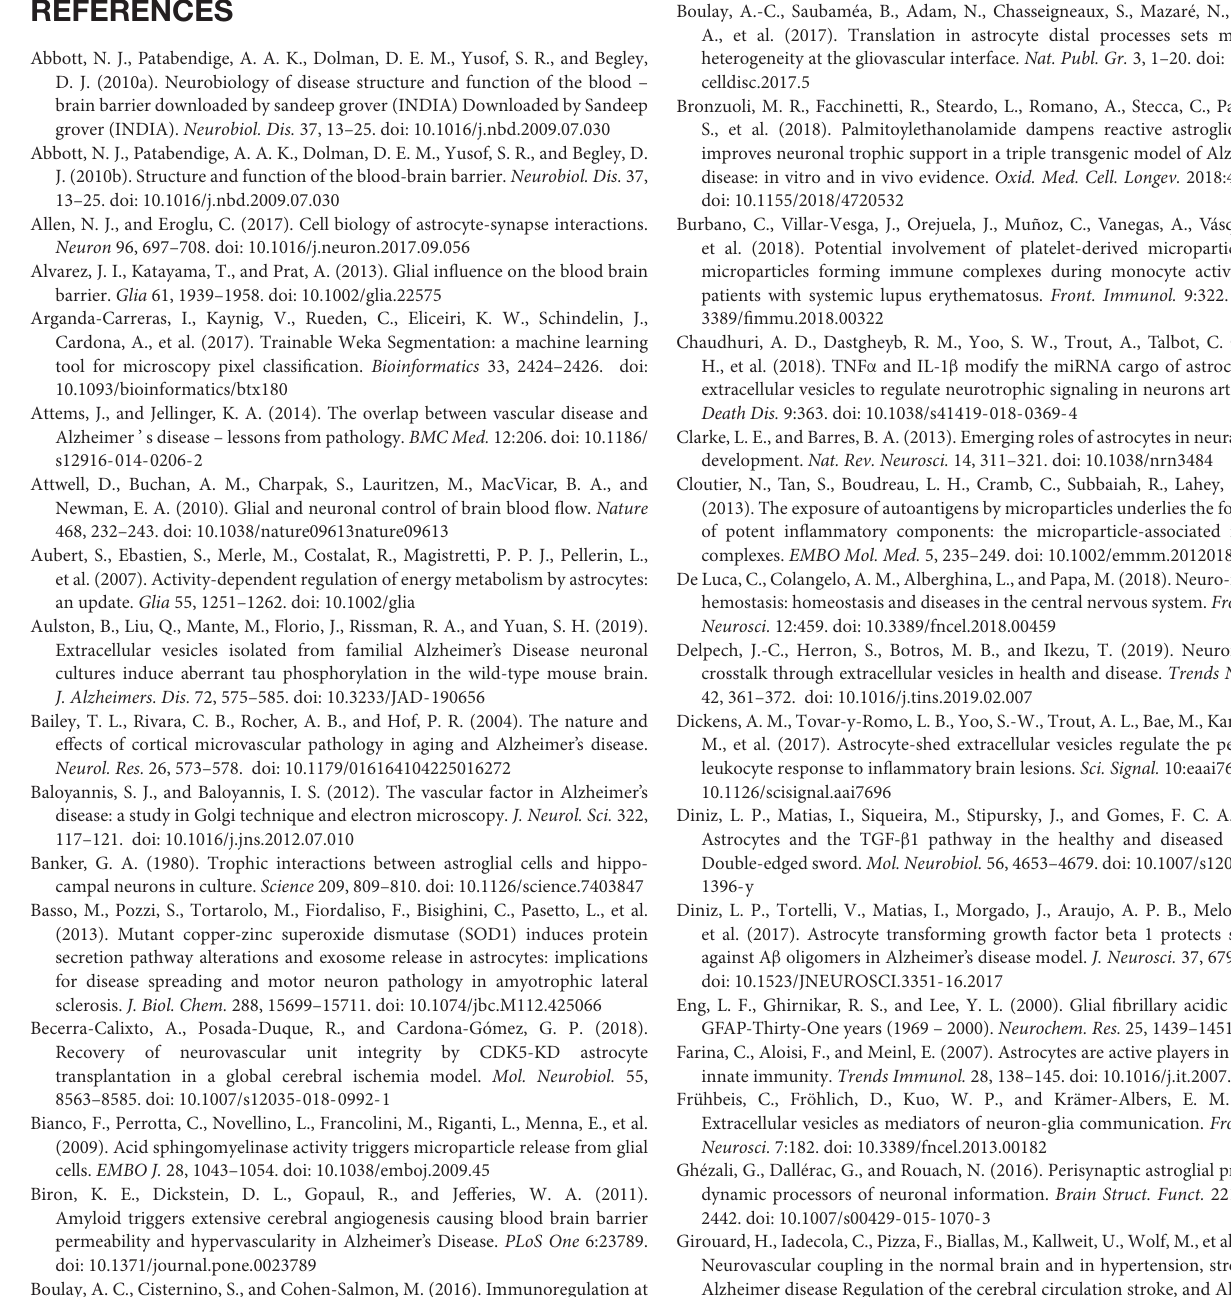
axis showing structural defects such as gaps (indicated by arrowheads) and number of independent structures (numbered; structures in the edges were excluded). (B) Fold change over CNT revealing that blood vessels in SAD display much more gap areas (SAD = 772.73, and FAD = 218.86%) and more independent structures (SAD = 368.58, and FAD = 190.84%) than those in CNT and FAD. Noteworthily, FAD tends also to be higher than CNT in both parameters. Scale bar: 20 µ m. Data are presented as mean ± SEM from CNT n = 5, SAD n = 7, and FAD n = 4; independent experiments. Levels of significance were set to ∗ p < 0.05 and ∗∗ p <